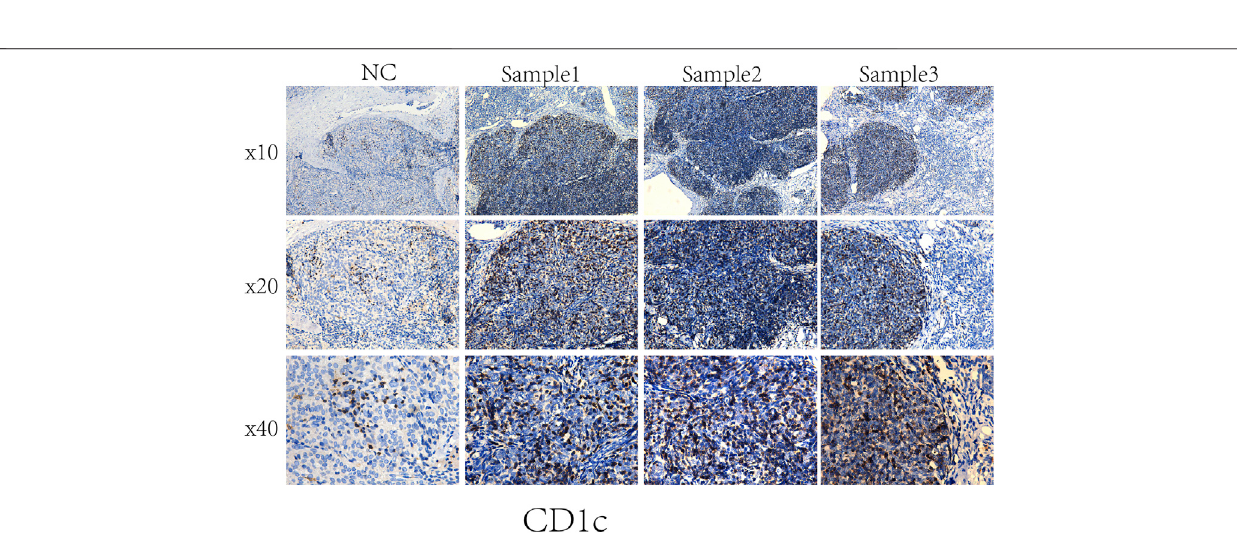
Frontiers in Genetics | www.frontiersin.org February 2022 | Volume 13 | Article 668696